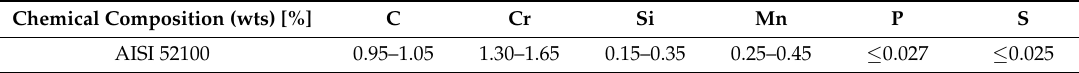
Table 1. Chemical composition (in wts %) of AISI 52100 bearing